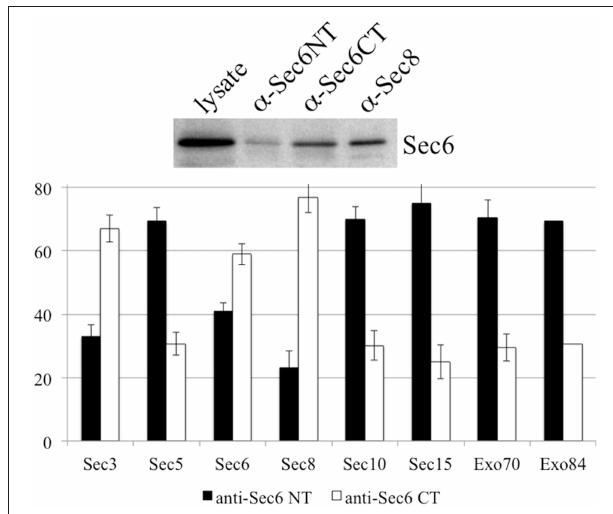
FIGURE 11 | Antibodies to different Sec6 domains differentially co-precipitate other exocyst subunits. Cocktails of antibodies specific for epitopes in either the Sec6 N-terminus (8F9, 10D11, 13F10, 8A11, 1F5, 7C6, 16G4, and 22F) or C-terminus (9E9, 9H5, 10C3, 2B12, 3F3, 8E6, 11A2, and 8A5) were used to immunoprecipitate exocyst complexes from MDCK lysates. Precipitates were resolved by SDS-PAGE and immunoblotted with antibodies to either Sec6 or indicated exocyst subunits. Amounts of each subunit that were recovered were normalized to amounts of Sec6 recovered in each immunoprecipitate, and are expressed as a fraction of the total immunoprecipitated by both Sec6 NT and CT antibody cocktails. Bars represent means of three independent experiments, and error bars represent standard